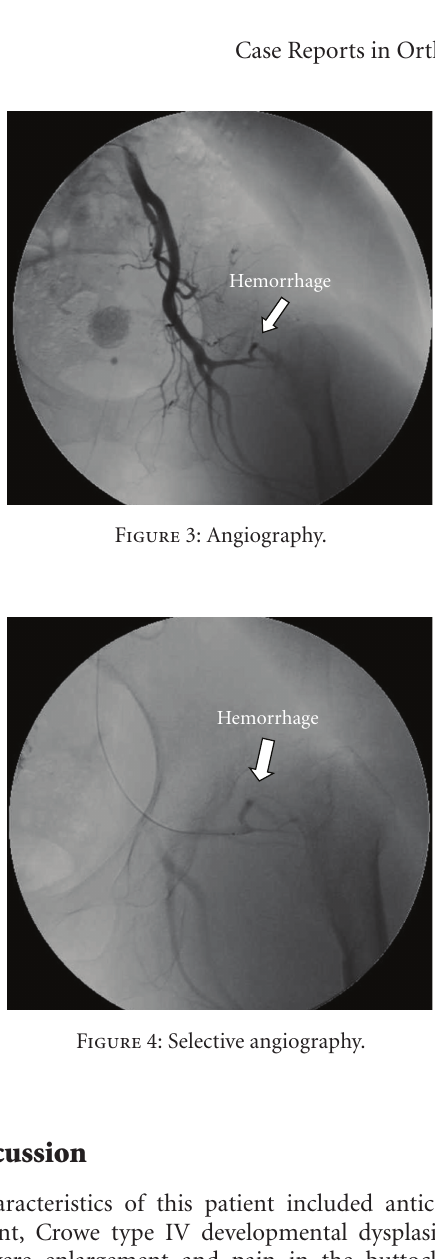
Figure 4: Selective